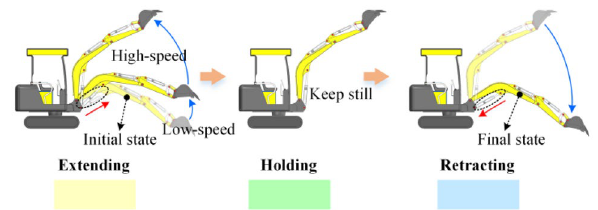
Figure 5 Schematic diagram of the boom movement